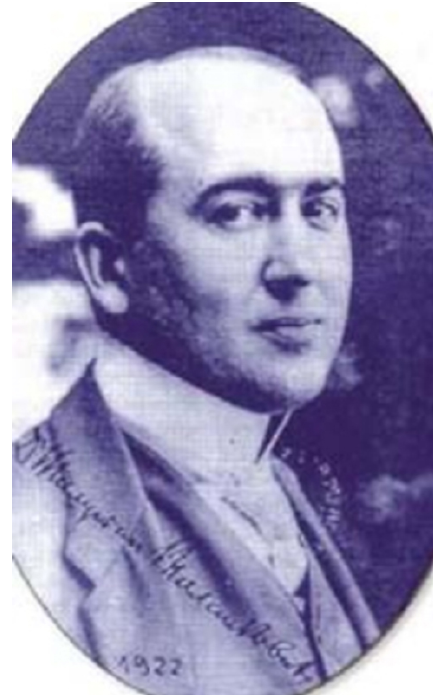
Figure 1. Milutin Milankovitch, signed photograph from 1922 (public domain).